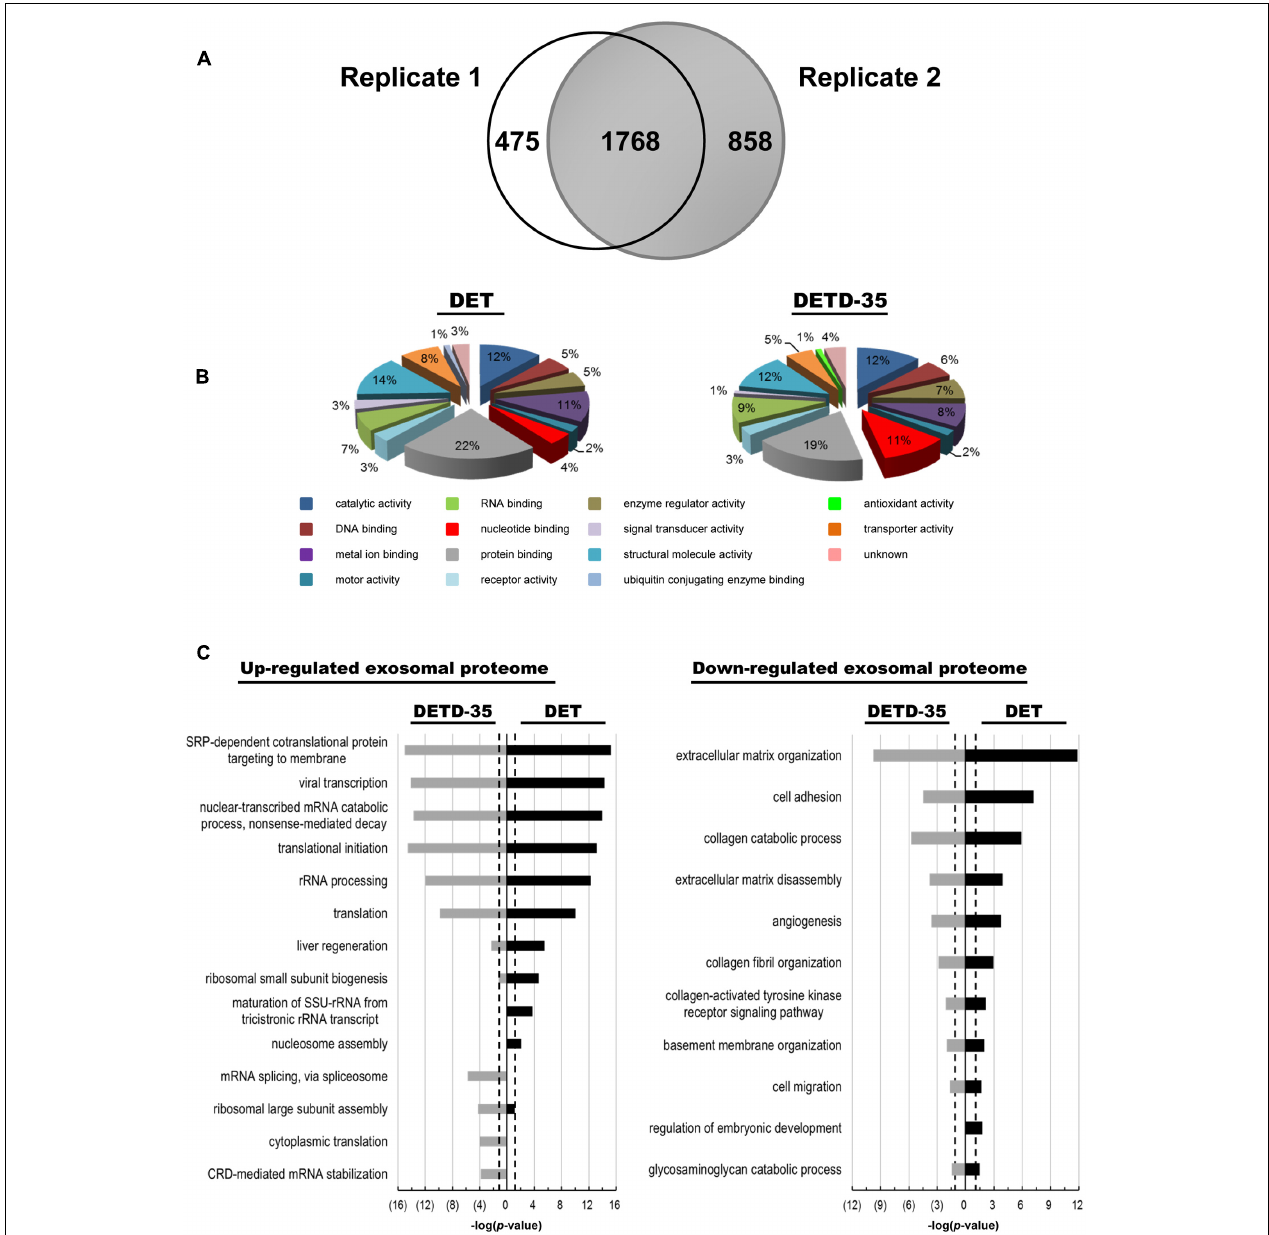
FIGURE 5 | Comparison of exosomal proteome originated from DET– and DETD-35–treated MDA-MB-231 cells. (A) Venn diagram showing the overlapping and unique exosomal proteins between the two biological replicates in DET– or ETD-35–treated TNBC cells. (B) Molecular functions of significantly expressed compound-responsive exosomal proteins were classified based on the gene ontology (GO) categorization. (C) The significantly differential expression of exosomal proteins responsive to both compound treatments were clustered into groups according to the GO biological processes terms by DAVID Bioinformatics tools. The top 10 significantly enriched biological processes of the up- and down-regulated protein expressions in the exosomal proteome were selected out, and ranked on the basis of based on –log( p -value) value high than 1.3 ( P < 0.05). The black dotted line indicates –log( p -value) value of 1.3 as the threshold for statistical